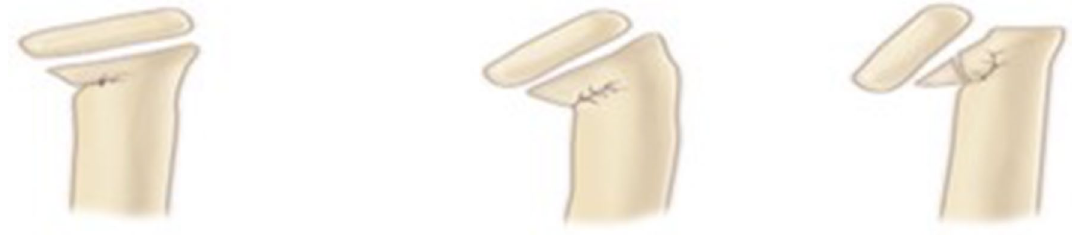
Figure1. Classification of radial neck fractures in children(O’Brien